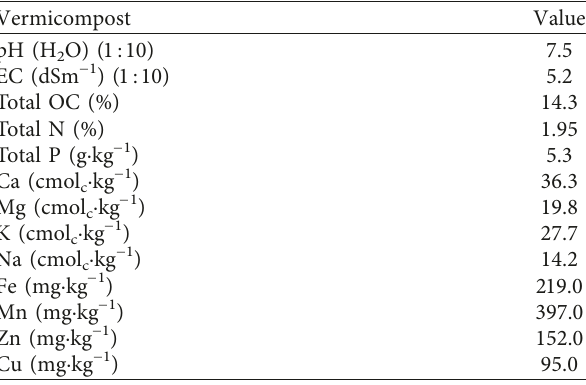
Table 2: Chemical characterization of